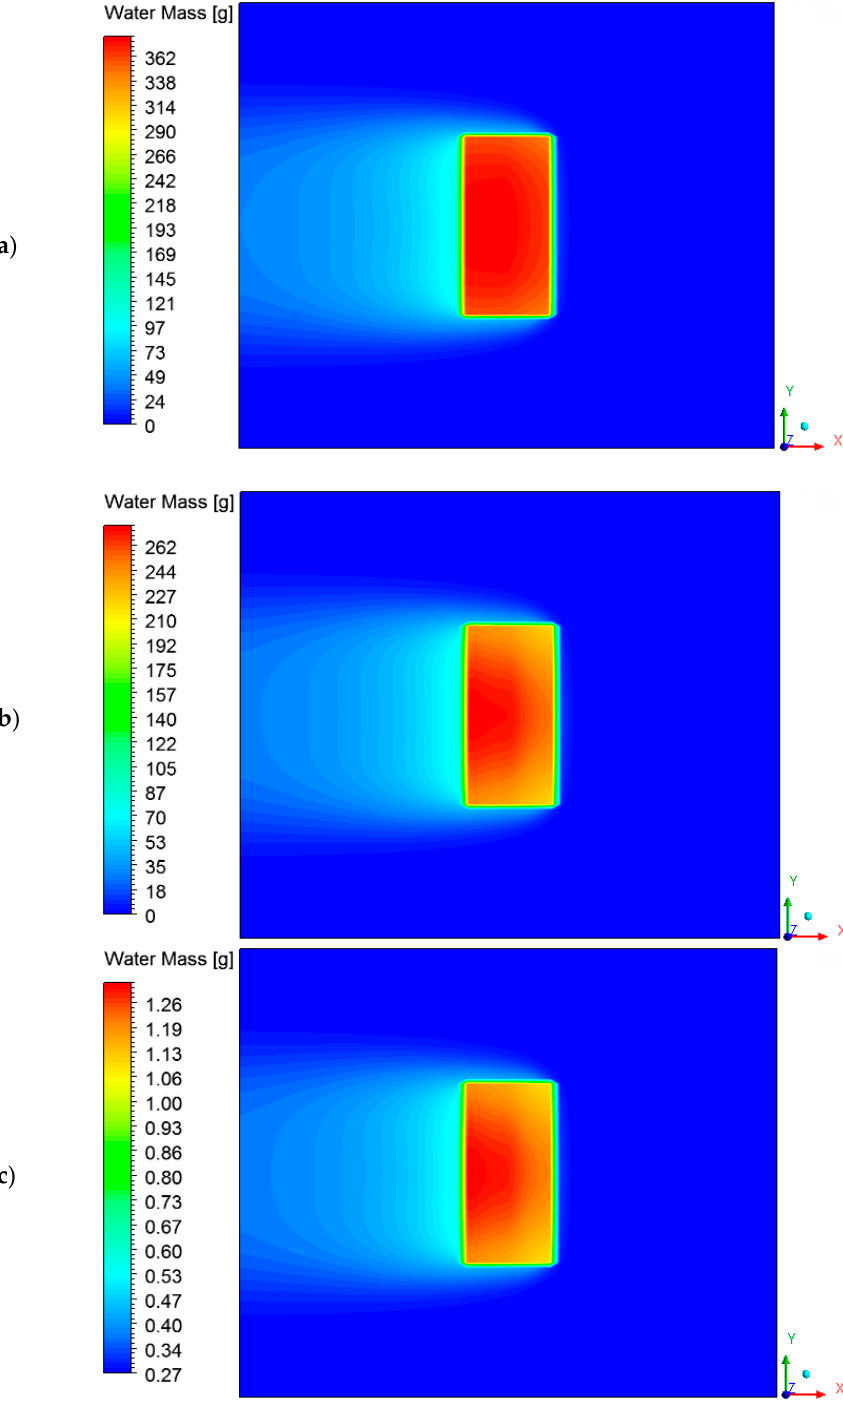
Figure 14. Water mass fields of the air in a plane XY (Z = 0.197 m) at different moments of drying: ( a ) 10 min, ( b ) 60 min, and ( c ) 950 min.